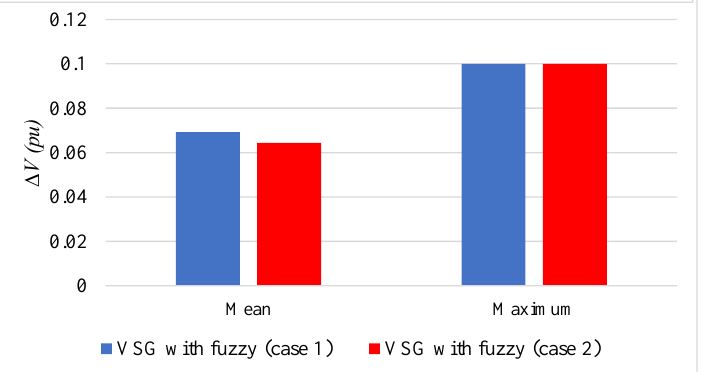
Figure 29. Voltage response statistics of the system for the scenarios presented in Section 4.2.